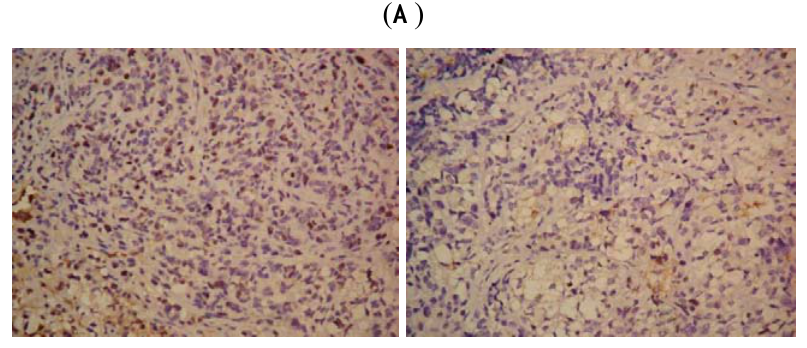
Figure 3. Cell proliferation in xenograft tumors of nude mice treated with SC-560, celecoxib or/and taxol. ( A ) Immunostaining of cell proliferation (Ki-67)